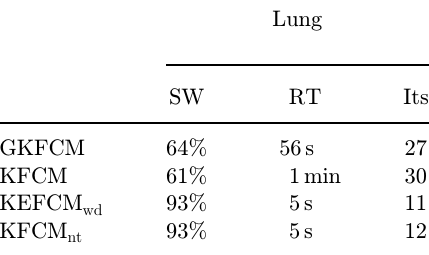
Table 3. Comparison of Iteration Count (Its), Running Time (RT) and clustering accuracy (SW).